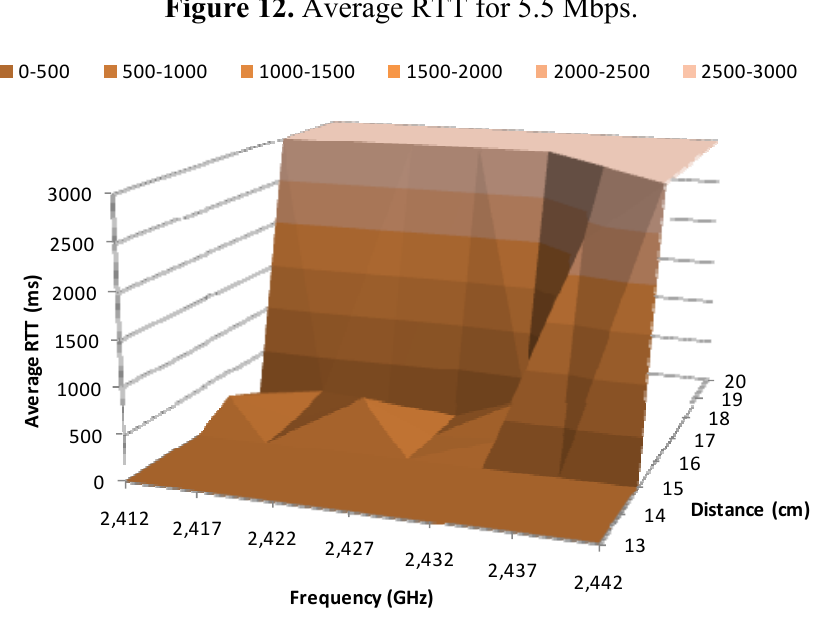
Figure 12. Average RTT for 5.5